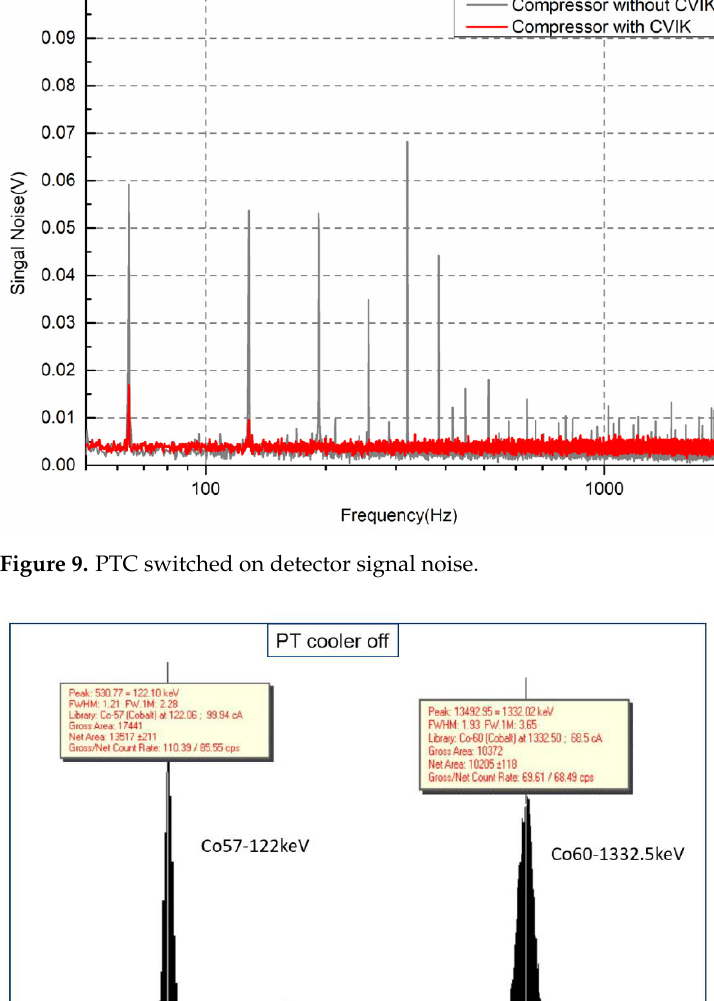
Table 5. Heat links isolation performance measurement results summary.